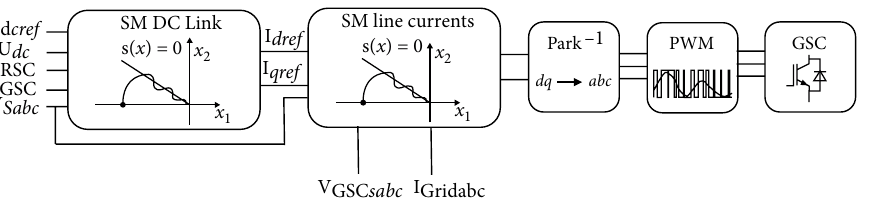
Figure 9: Control scheme of the GSC using the SM controller.